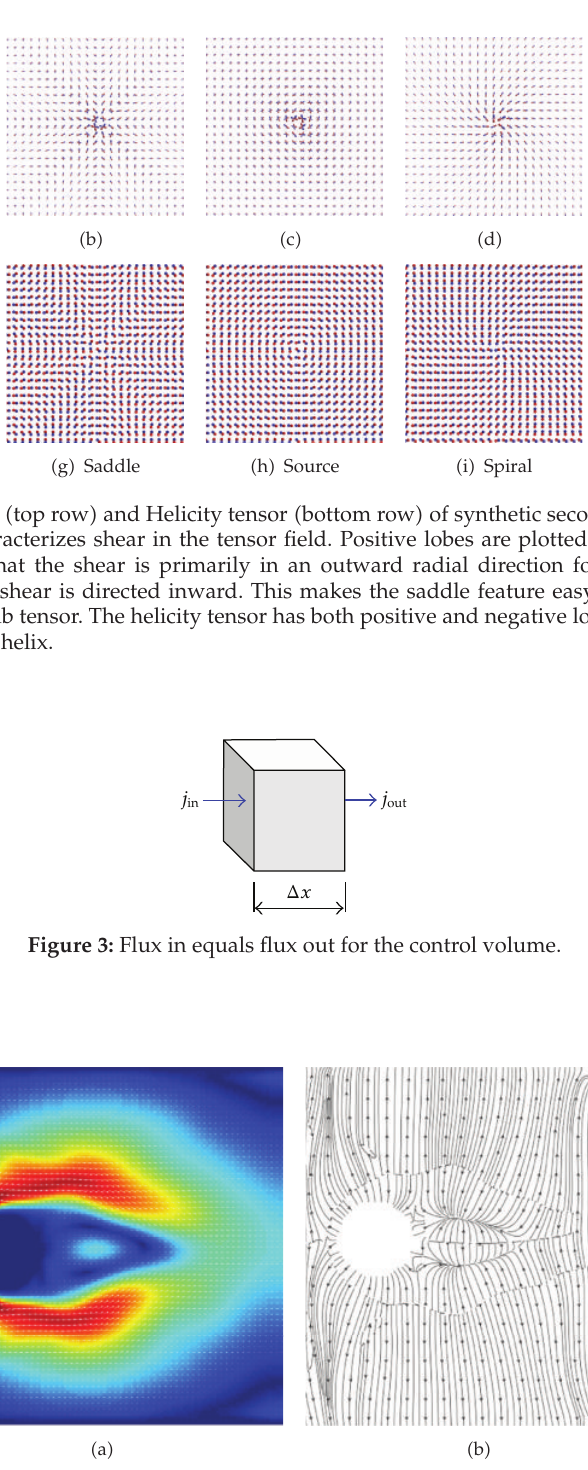
Figure 4: A slice of a 3D velocity field for fluid flow around a cylinder (cid:3) a (cid:4) and streamlines of the corresponding Lamb vector field (cid:3) b (cid:4)